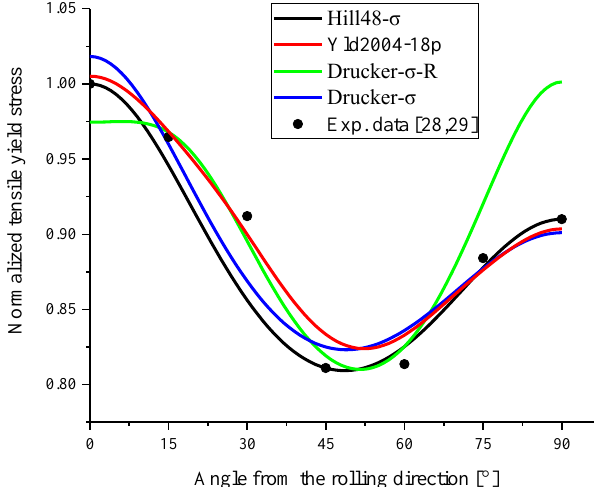
Figure 3. The normalized tensile yield stresses with four yield functions for AA 2090-T3 sheet.